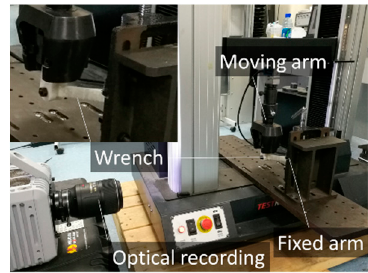
Figure 4. Experimental setup used to test the 3D printed cellular